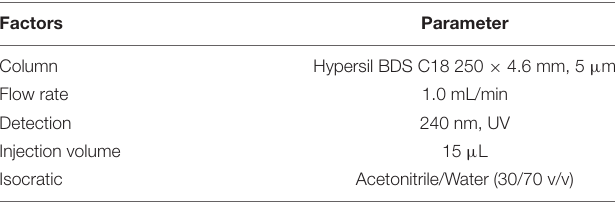
TABLE 1 | HPLC methods used for measuring cymoxanil (CYM) concentrations.